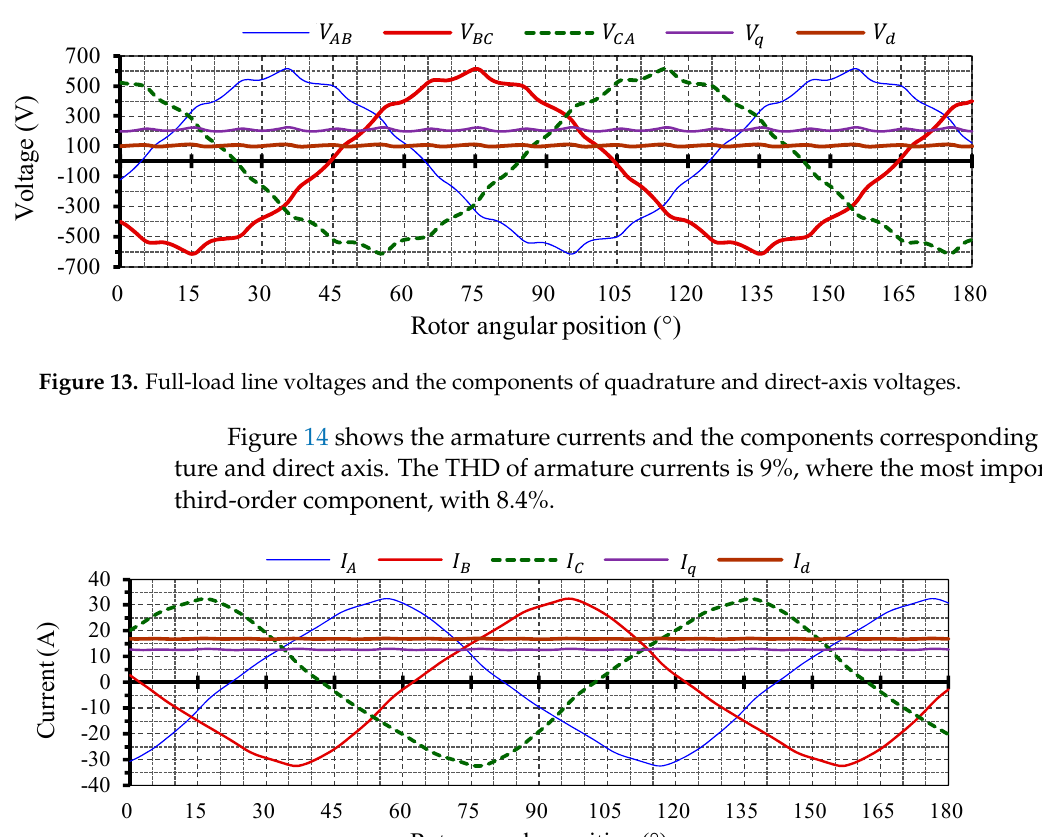
Figure 12. No-load phase voltages (field current equal to I Fnl ). The phase-to-phase voltages under full-load operation and the components of the voltage in the quadrature and direct axis are shown in Figure 13. The variables V q and V d are the quadrature and direct axis components of the voltage obtained from phase voltages by Park’s reference frame transformation [22]. The flux distortion caused by armature reaction generally contributes to reducing the harmonic content of the voltage. The THD of the line voltages presented in Figure 13 is 3%, whereby the eleventh—(1.2%) and the thirteenth—(2.5%) order components are the most important.